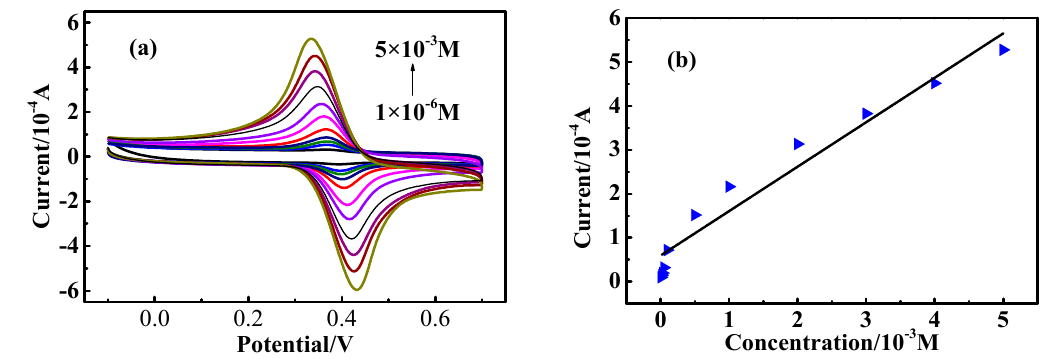
Figure 7. Cyclic voltammograms of ZCF-modified GCE with the HQ concentration between 1 × 10 − 6 ~5 × 10 − 3 mol/L at a scan rate of 20 mV/s ( a ) the current varies with the HQ concentration; ( b ) the relation curve of oxidation peak current and HQ concentration.